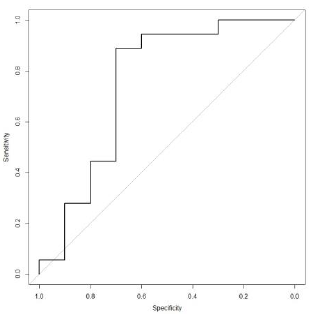
( e ) ROC curve of RF— Ⅲ model, AUC = 0.76 ( f ) ROC curve of GBM— Ⅲ model, AUC = 0.86